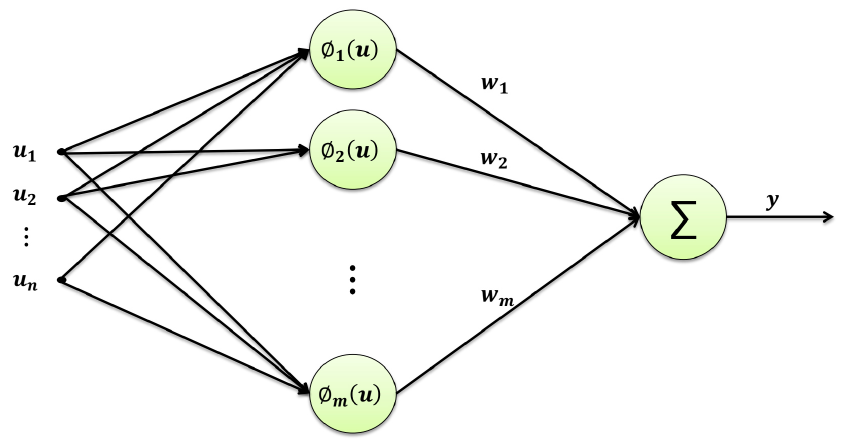
Figure 1. A regular